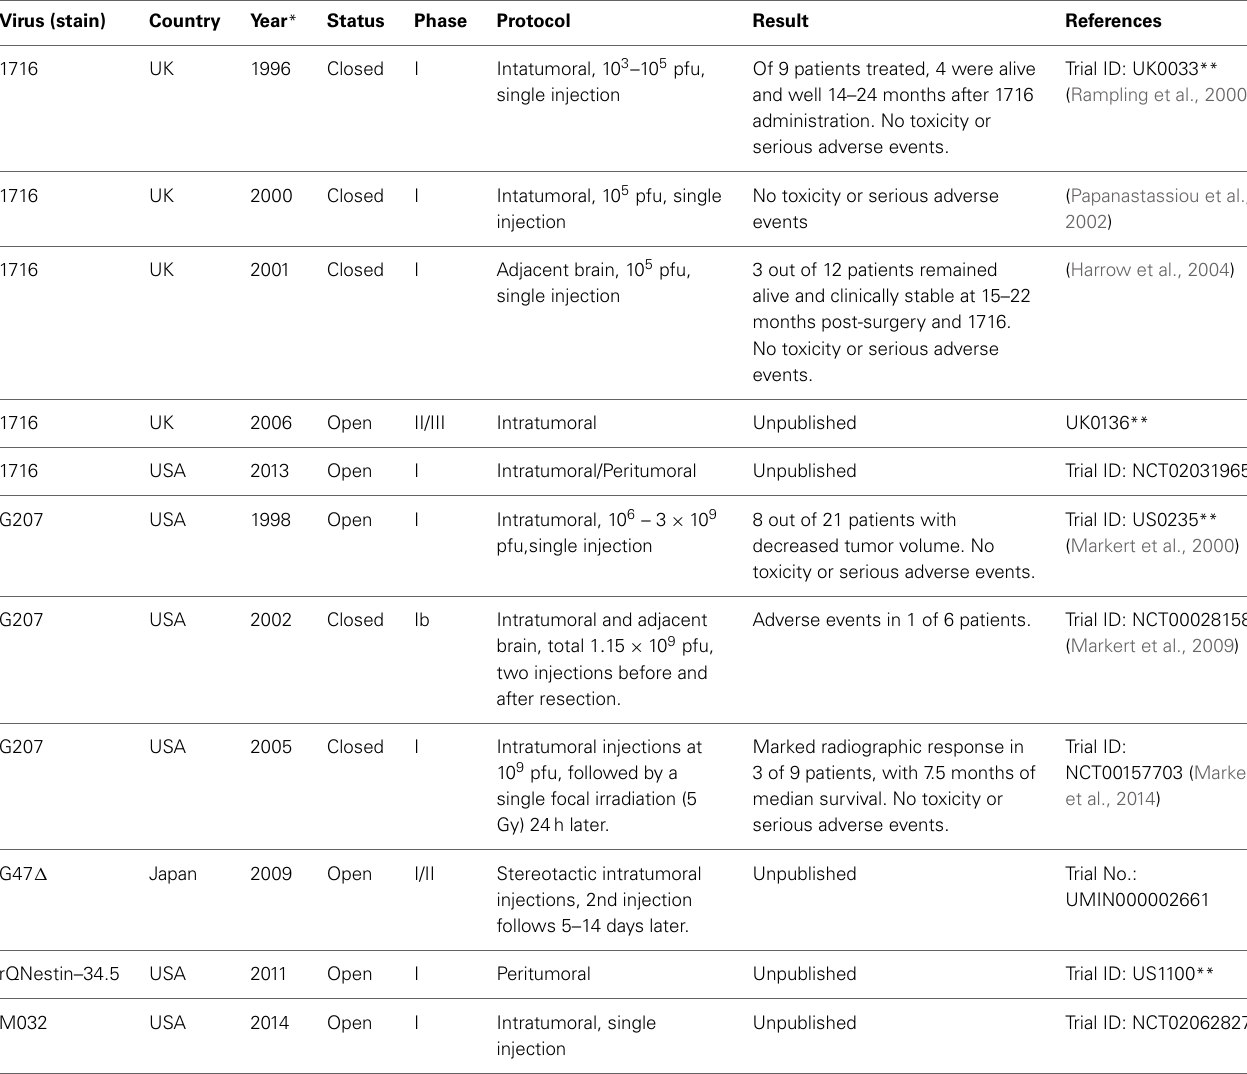
Table 1 | Oncolytic herpes simplex viruses in completed and ongoing clinical trials for malignant glioma. Virus